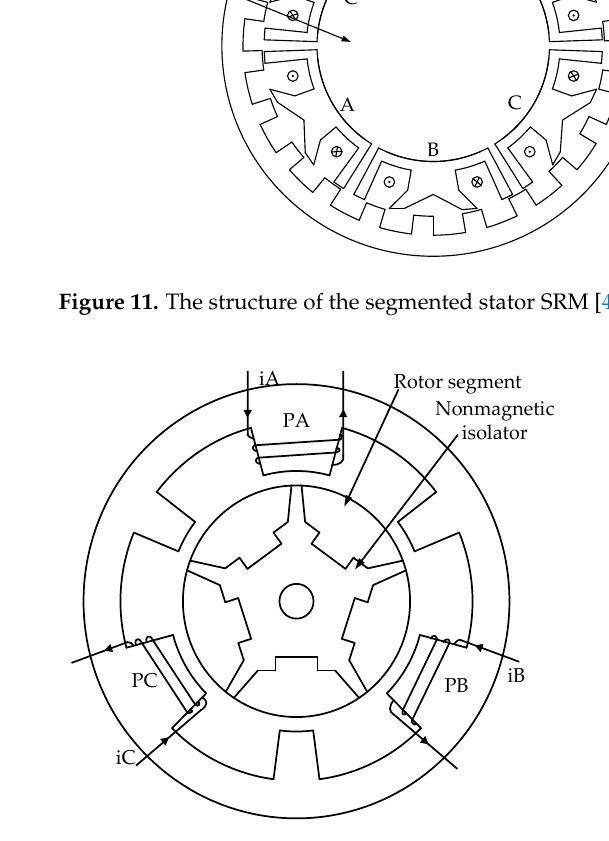
Figure 12. The structure of the segmented rotor SRM [38].